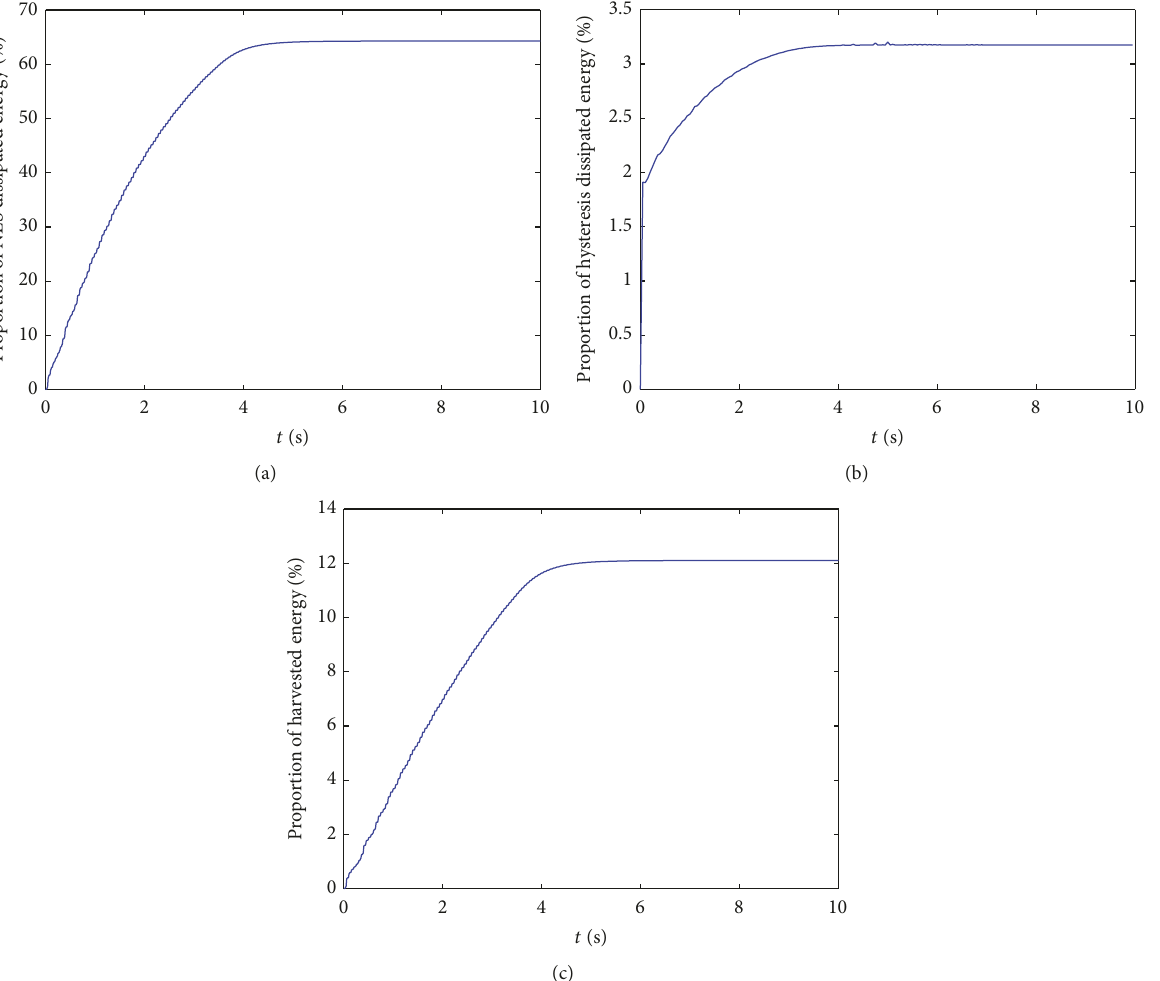
Figure5:Configuration2:(a)thepercentageofenergydissipatedbytheNESdamper;(b)thepercentageofenergydissipatedbythehysteresis behavior; (c) the percentage of energy harvested by the piezoelectric